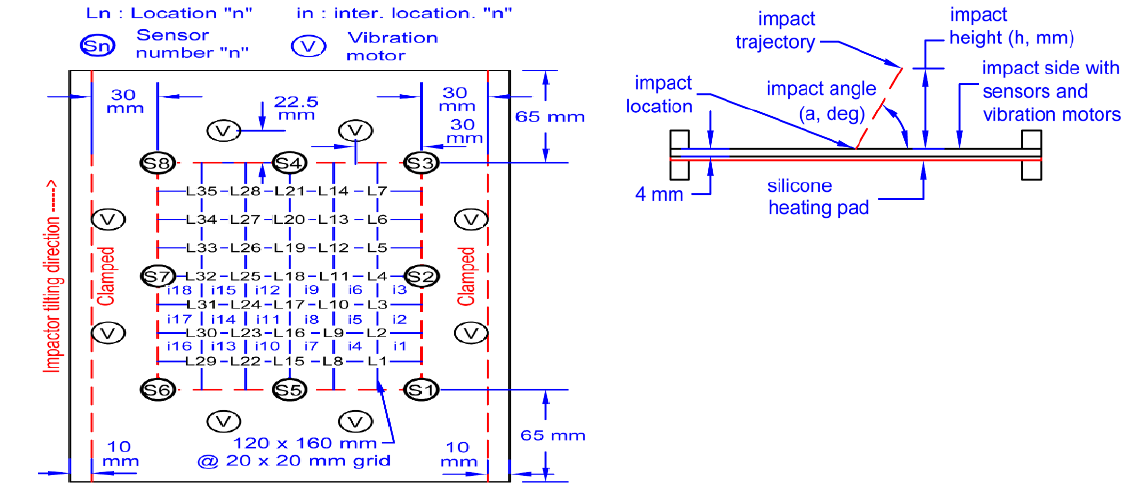
Figure 1. Sensor Figure 1. Sensor setup.